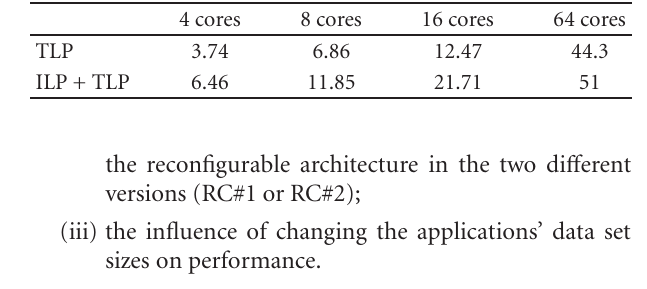
Table 2: Number of basic functional units of setups. Table 3: Average speedup on di ff erent number of